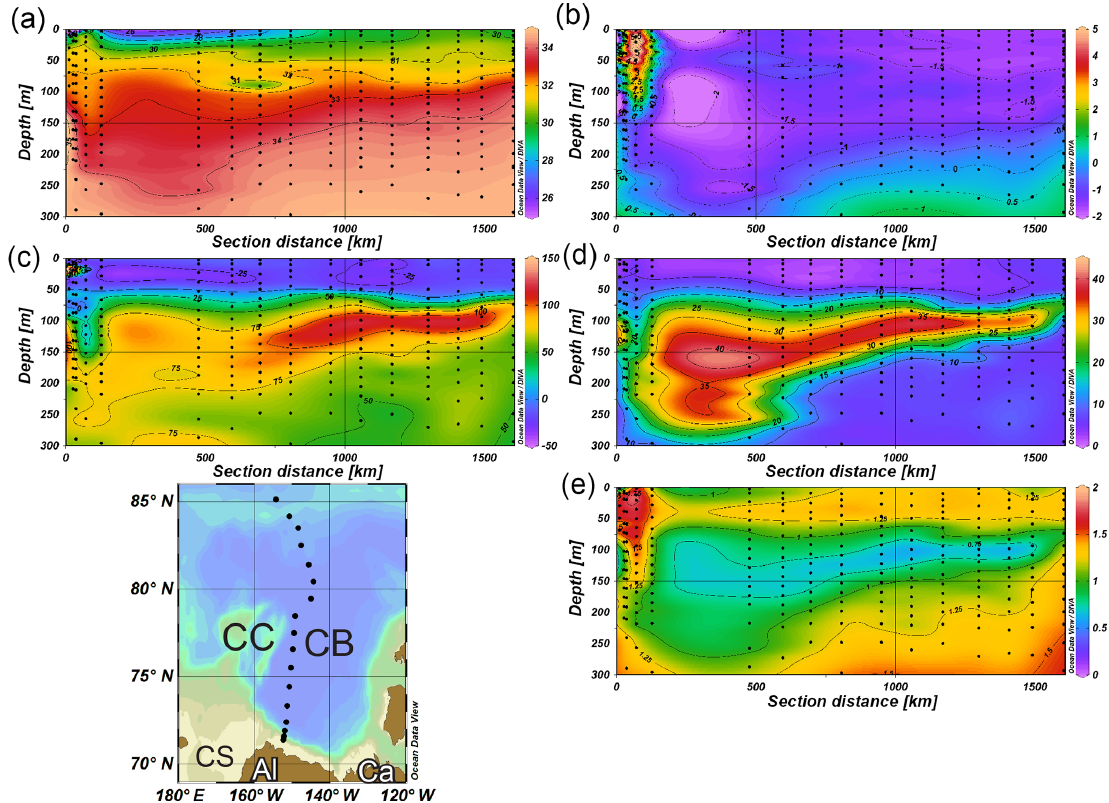
Figure 4. Sections of (a) salinity, (b) temperature, (c) AOU, (d) silicate, and (e) (cid:127) aragonite in the top 300m across the Canada Basin as observed during the Beringia 2005 expedition. Station positions are noted on the map, with the abbreviations being CB, Canadian Basin; CC, Chukchi Cape; CS, Chukchi Sea; Al, Alaska; and Ca,